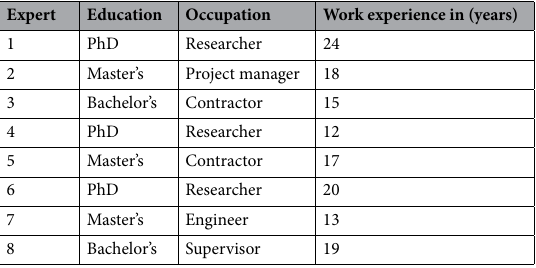
Table 2. Expert background information. Source: Authors’ compilation.